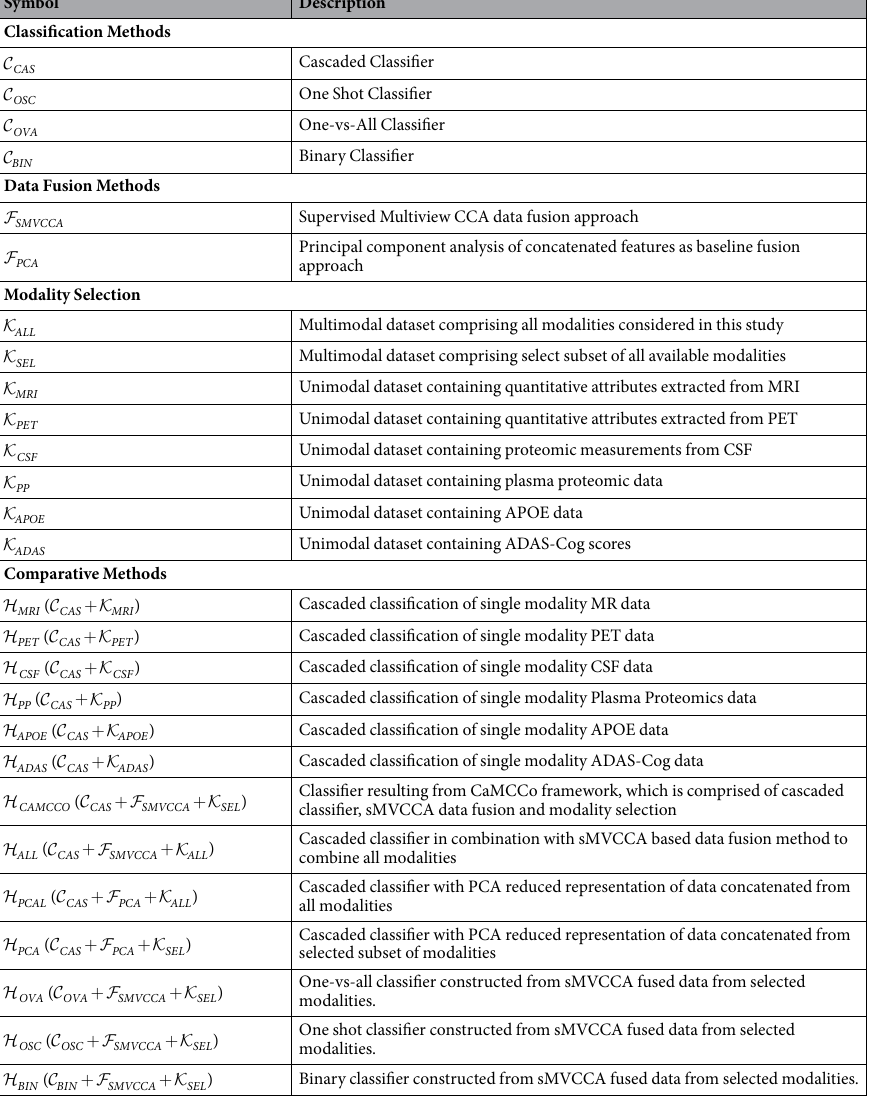
Experiment 2: Comparison of Multi-Class Classification Strategies for Fused Predictors. Table 6  ,   for prediction of HC, MCI and AD. Across all 3 classes, it is shows the performance of and CAMCCO OVA OSC  and  outperform  .  and  show comparable AUCs for AD classifi- evident that OVA CAMCCO OSC OVA CAMCCO  . shows incrementally higher accuracy, sensitivity and specificity as compared to cation, although  OVA CAMCCO significantly outperforms  in terms of all metrics (OVA For MCI classification however,  CAMCCO OVA AUC = 0.78 vs. CaMCCo AUC = 0.88). This is on account of the lower classification performance of MCI vs. all which is a challenging task provided the heterogeneity of the ‘all’ category which consists of both AD and HC patients. Therefore, CaMCCo provides the most optimal performance overall, across all 3 classes. Experiment 3: Evaluation of Fused Representation on Binary Classification Tasks. Table 7 shows  results obtained by combining select few modalities (  ) via sMVCCA (  ) for the following binary BIN SEL SMVCCA classification tasks: (i) AD vs. HC and (ii) MCI vs. HC. On the training set, the fusion of ADAS-Cog and CSF provided the best classification AUC for AD vs. HC whereas the fusion of ADAS-Cog, CSF and PET provided the